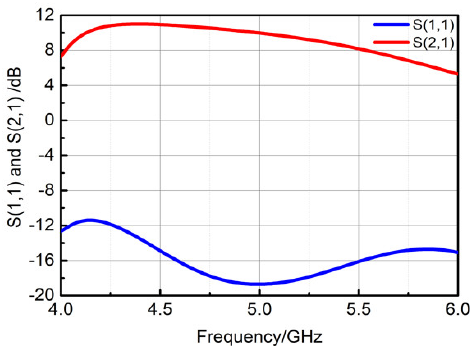
Figure 11. The Simulation of S-parameters.